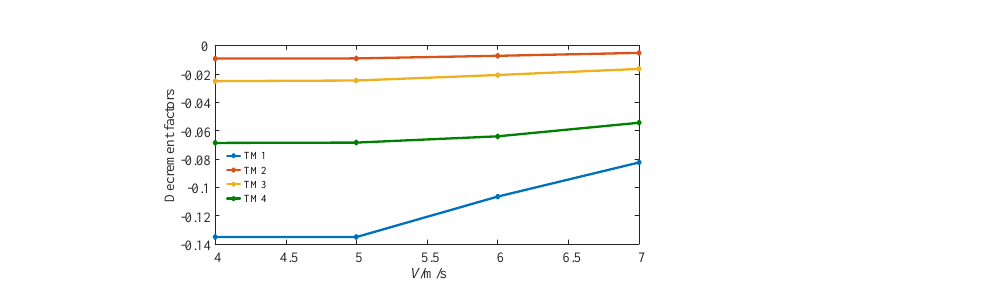
Table 1. Damping coefficient for TM1 of SG under different K p